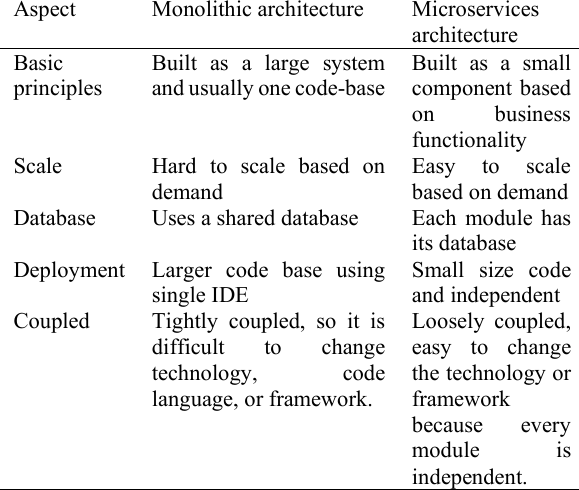
Table 1. Differences between Microservices and Monolithic architecture [8].